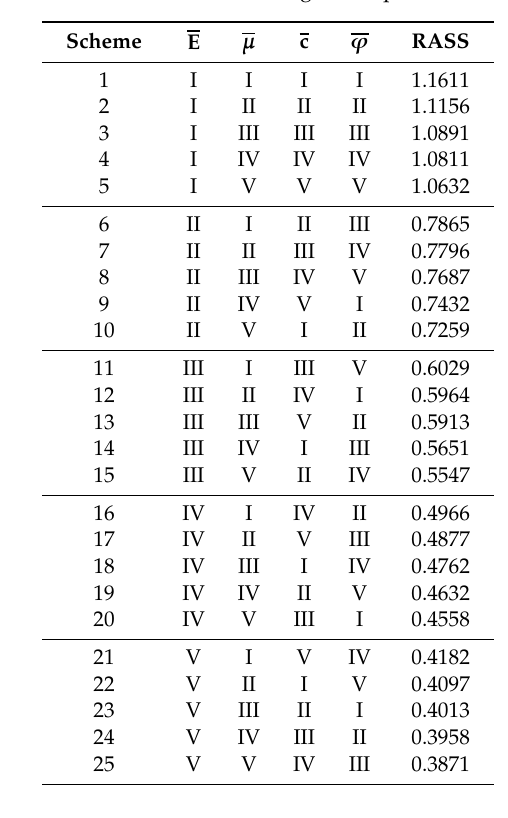
Table 4. The results table of orthogonal experimental design.